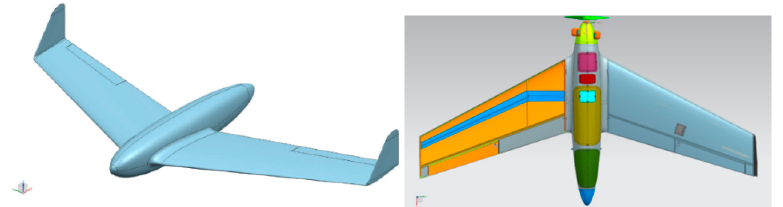
Figure 2. Geometry of “HORNET” unmanned aerial vehicle (UAV): skin ( left ) and internal structure ( right ).